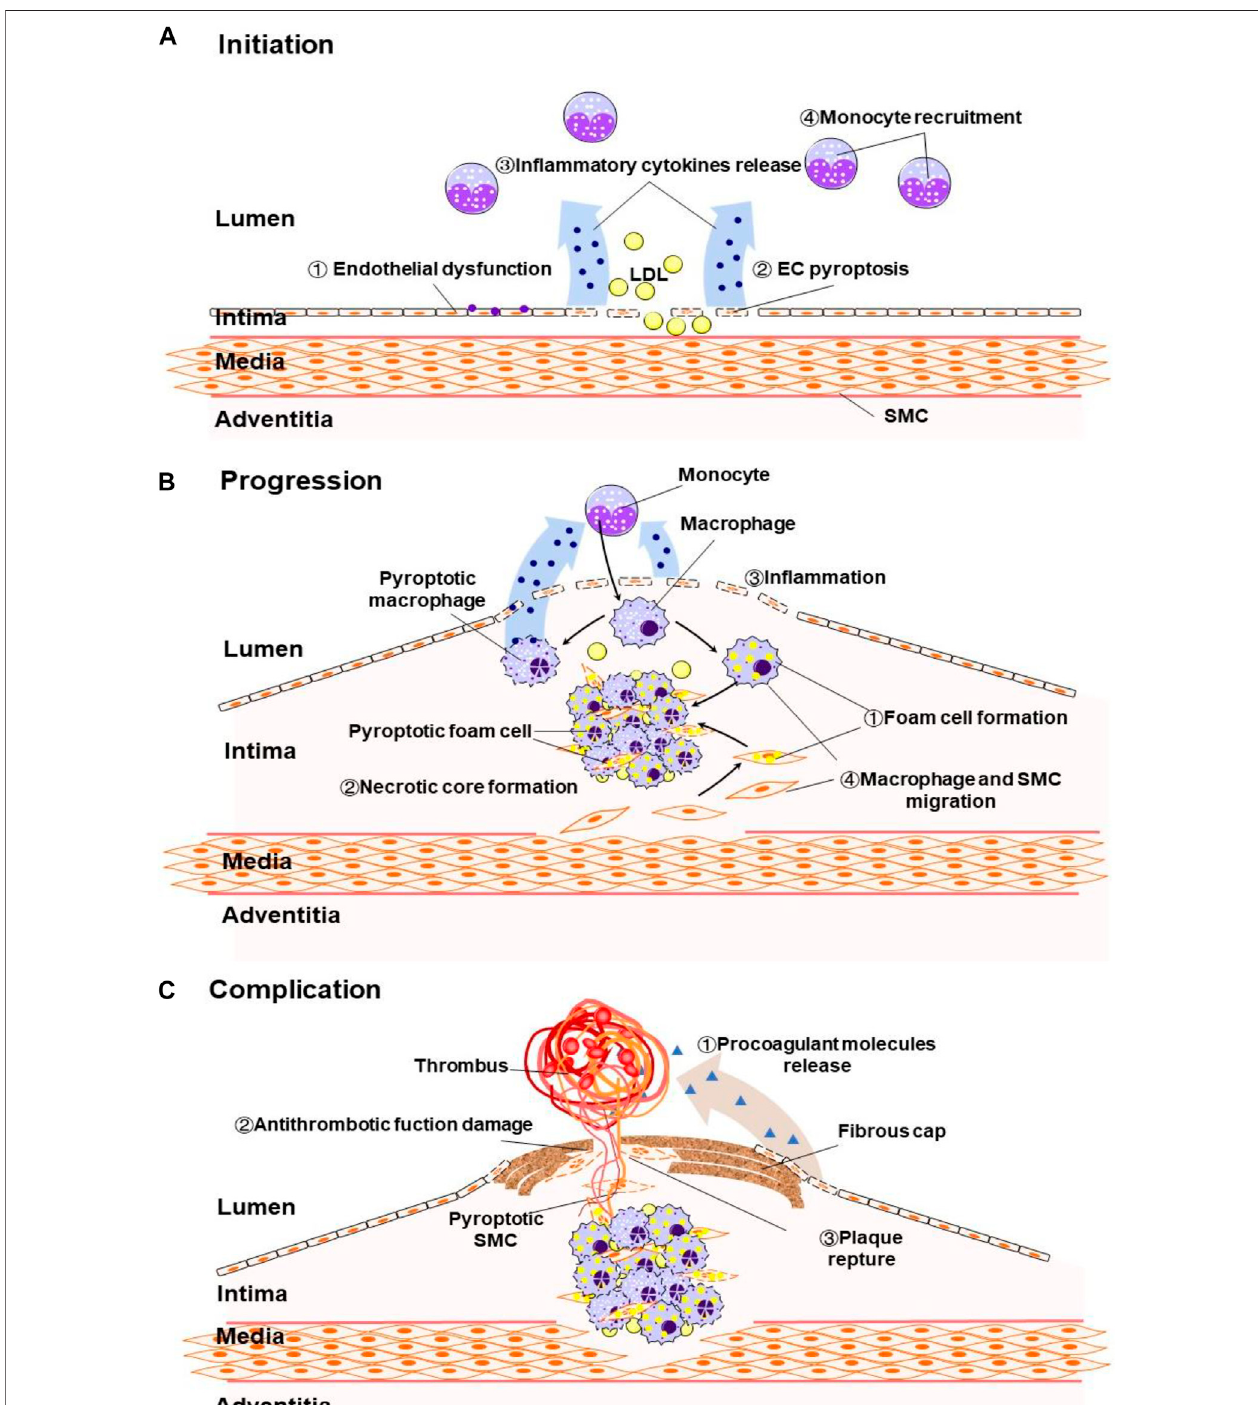
FIGURE 2 | (A) Pyroptosis induce endothelial dysfunction, ECs death, in fl ammatory cytokines release and monocyte recruitment in at the early stage of atherosclerosis. (B) Pyrotosis induce foam cell formation and macrophage and SMC migration, increase in fl ammation and necrotic core formation in the advanced atherosclerosis. (C) Pyroptosis induce release of procoagulant molecules, thin the fi brous cap and promote plaque reptrue.